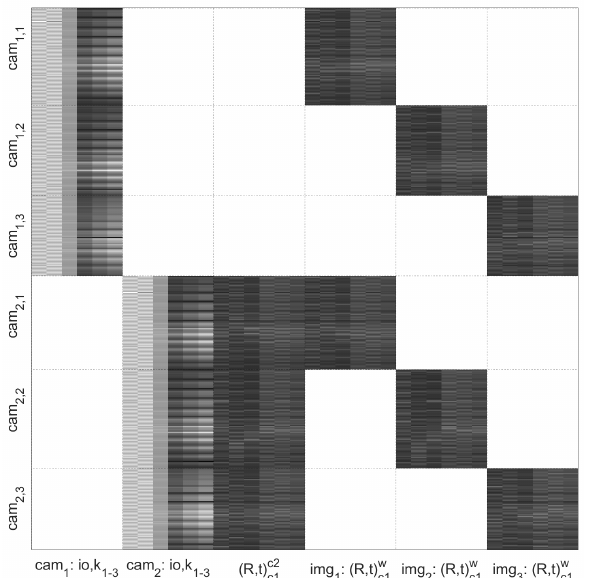
Figure 4: Jacobi matrix example for a stereo camera calibration with 3 poses. Matrix entries are scaled for better visibility.